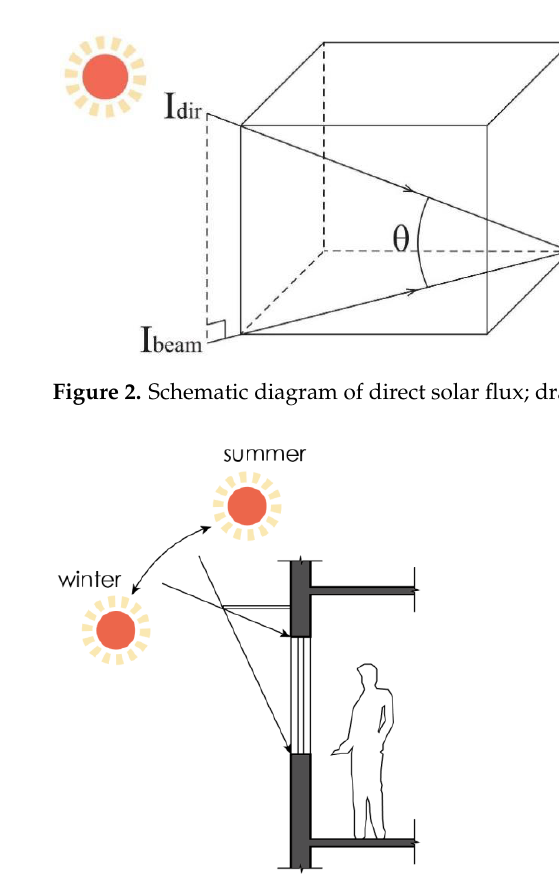
Figure 3. Schematic diagram showing change in solar altitude angle on window receiving solar radiation; drawn by the authors.